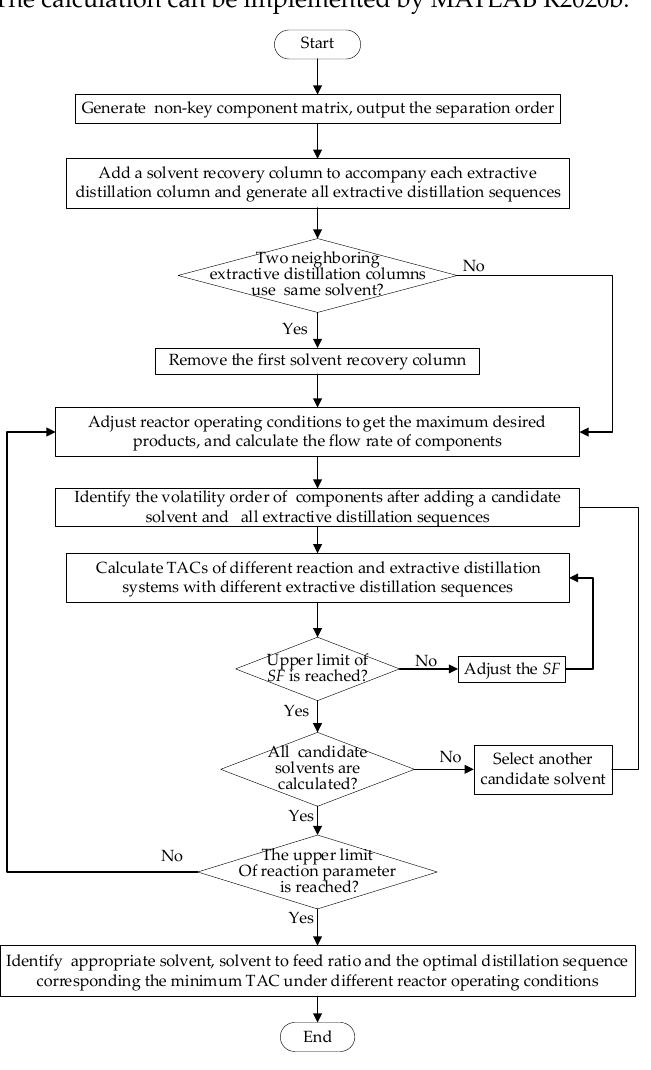
Figure 5. Procedure for identifying the optimal solvent and distillation sequence.